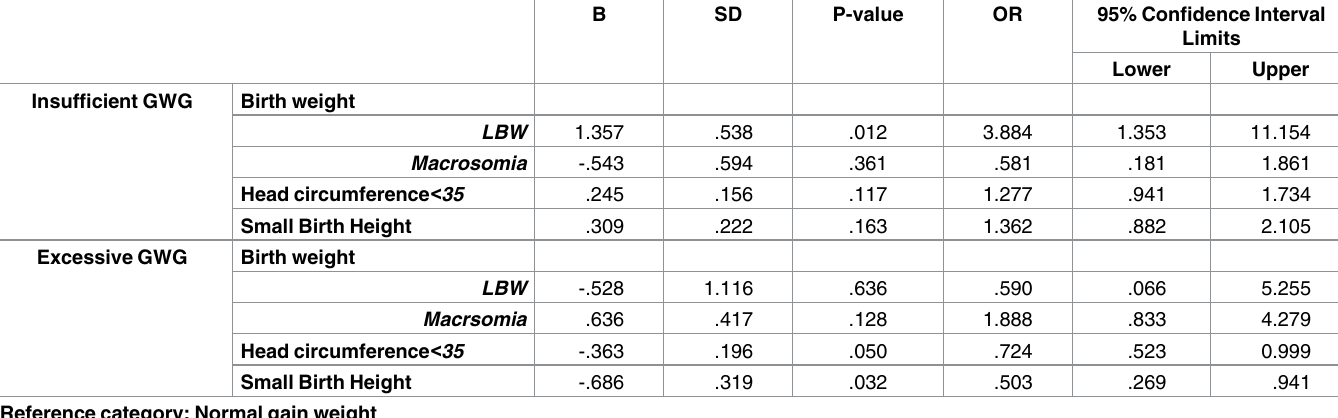
Table 9. Multivariate logistic regression analysis of the association between GWG and neonatal